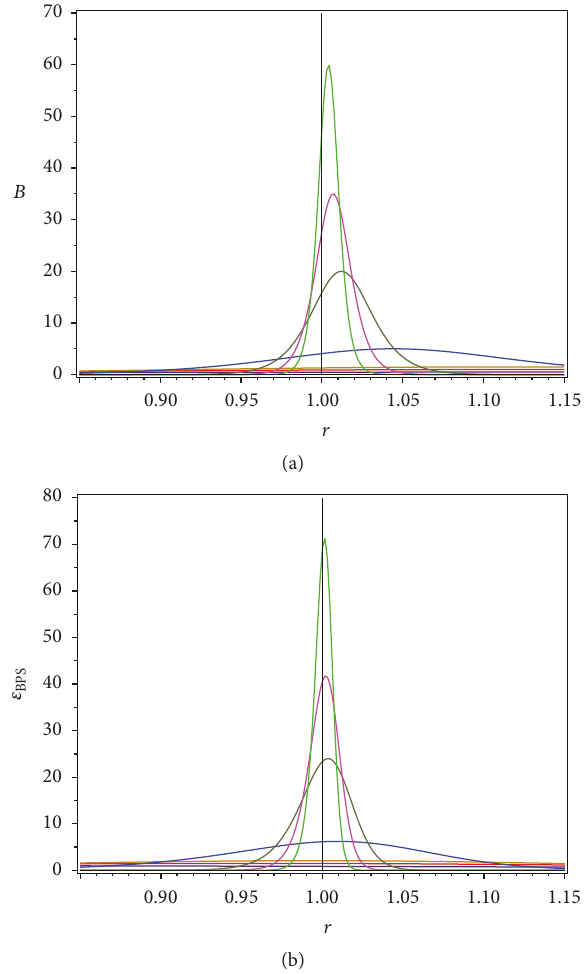
Figure 6: The magnetic field 𝐵(𝑟) (a) and the BPS energy density 𝜀 BPS (𝑟) (b) come from the generalized Chern-Simons-Higgs model (69) with 𝜔(𝑔) = 𝜆𝑔 2𝜆−2 . Observe that 𝜆 = 1 (indigo lines) represents the usual CSH model and the true compacton solution is given by 𝜆 = ∞ (vertical black lines representing the 𝛿 -Dirac function). The convention for the color of the lines is the same given in Figure 5.